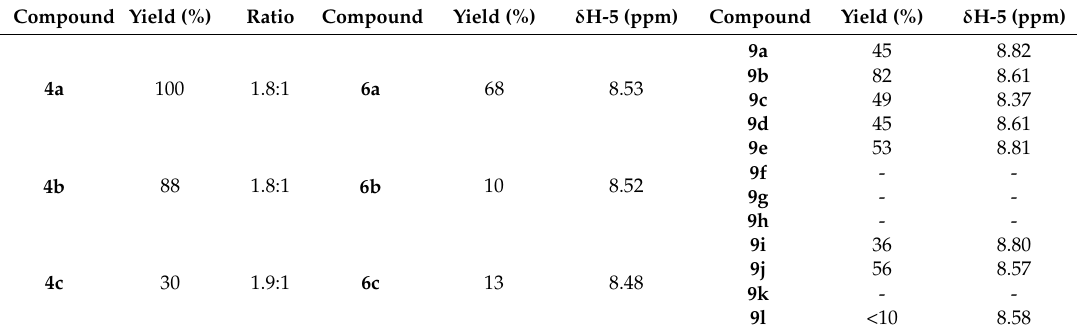
Table 1. Yields and NMR data for key compounds.